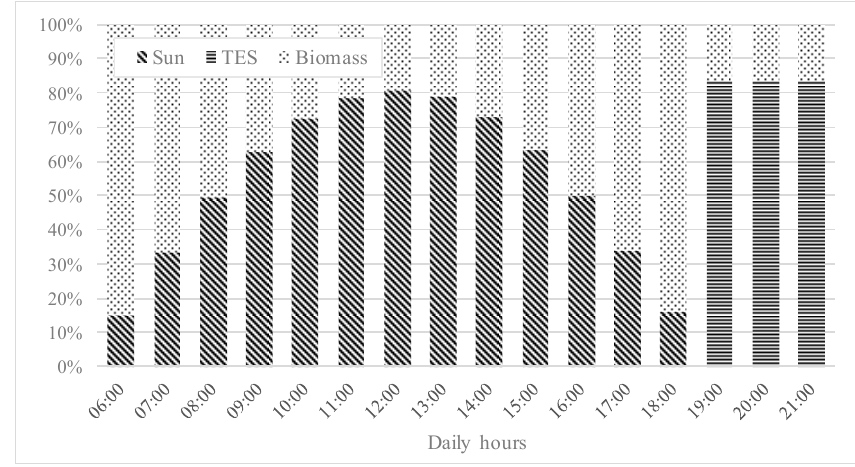
Figure 6. Hourly percentage division of the solar, biomass, and TES contribution for the 21st of June. The annual percentage division of the same contributions is 67.5% of the biomass contribution and 32.3% of solar one, for a global energy production of 805 MWh/y for the DEC plant and a TES contribution of about 185.8 MWh/y.